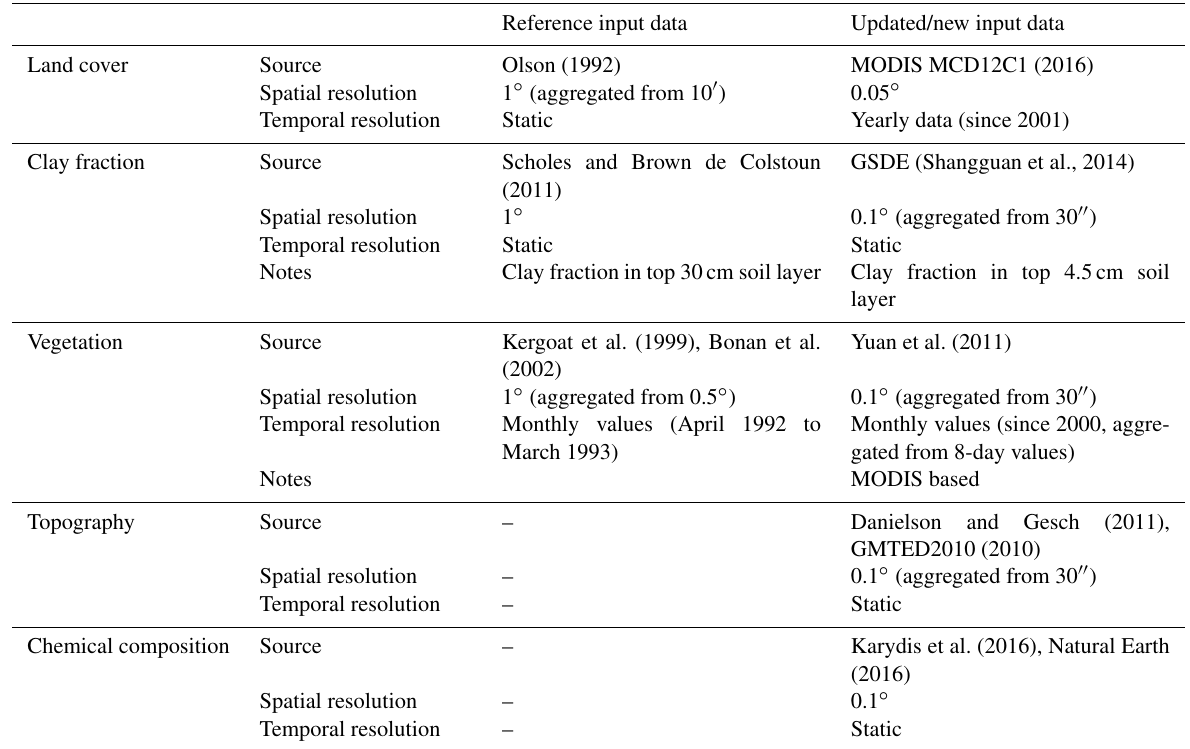
Table 1. Summary of updated and added input data.